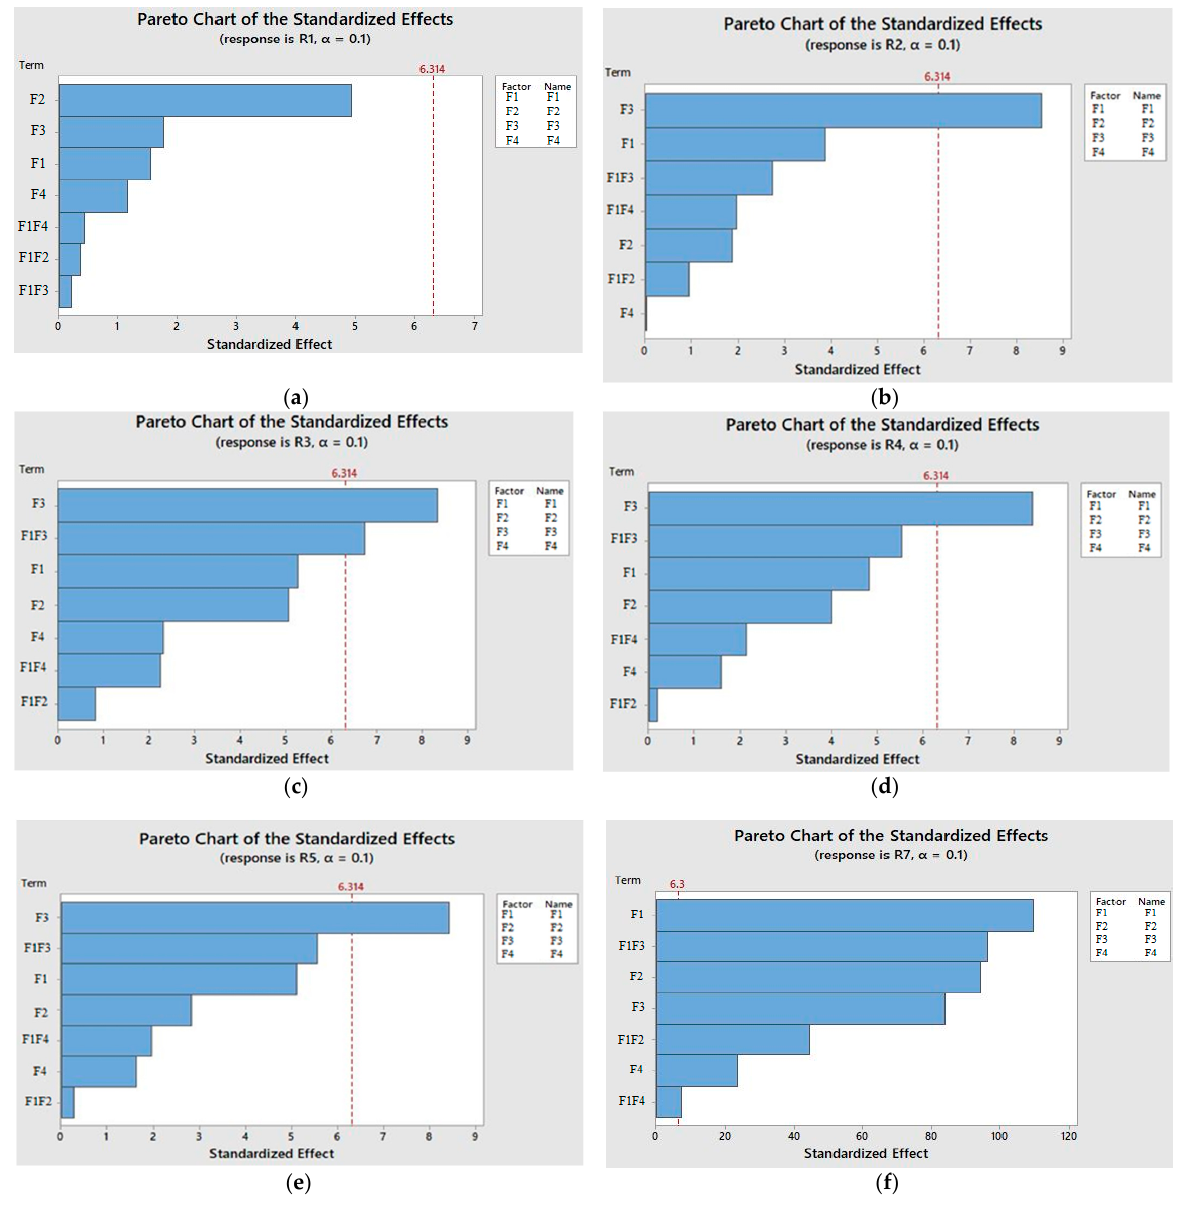
Figure 2. ( a ) Pareto chart of supercritical carbon dioxide (scCO 2 ) extract yield. ( b ) Pareto chart for the amount of cannabidiol (CBD) in supercritical carbon dioxide (scCO 2 ) extract. ( c ) Pareto chart for cannabidiolic acid (CBDA) in supercritical carbon dioxide (scCO 2 ) extract. ( d ) Pareto chart for the number of total cannabinoids in the supercritical carbon dioxide (scCO 2 ) extract yield. ( e ) Pareto chart for the amount of delta 9-tetrahydrocannabinol (D9 THC) in the supercritical carbon dioxide (scCO 2 ) extract yield. ( f ) Pareto chart for the amount of delta 9-tetrahydrocannabinolic acid (D9 THCA) in the supercritical carbon dioxide (scCO 2 ) extract yield. Table 6. HPLC quantification for delta 9-tetrahydrocannabinol (D9-THC), delta 9- tetrahydrocannabinol acid (D9-THCA), delta 8-tetrahydrocannabinol (D8-THC), cannabidivann (CBDV), and tetrahydrocannabivann (THCV) in the supercritical carbon dioxide extract. Std. Or-